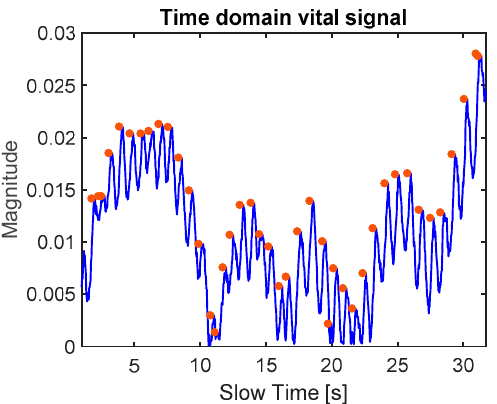
Figure 5. Peaks detected from vital signal reflected from human backside.